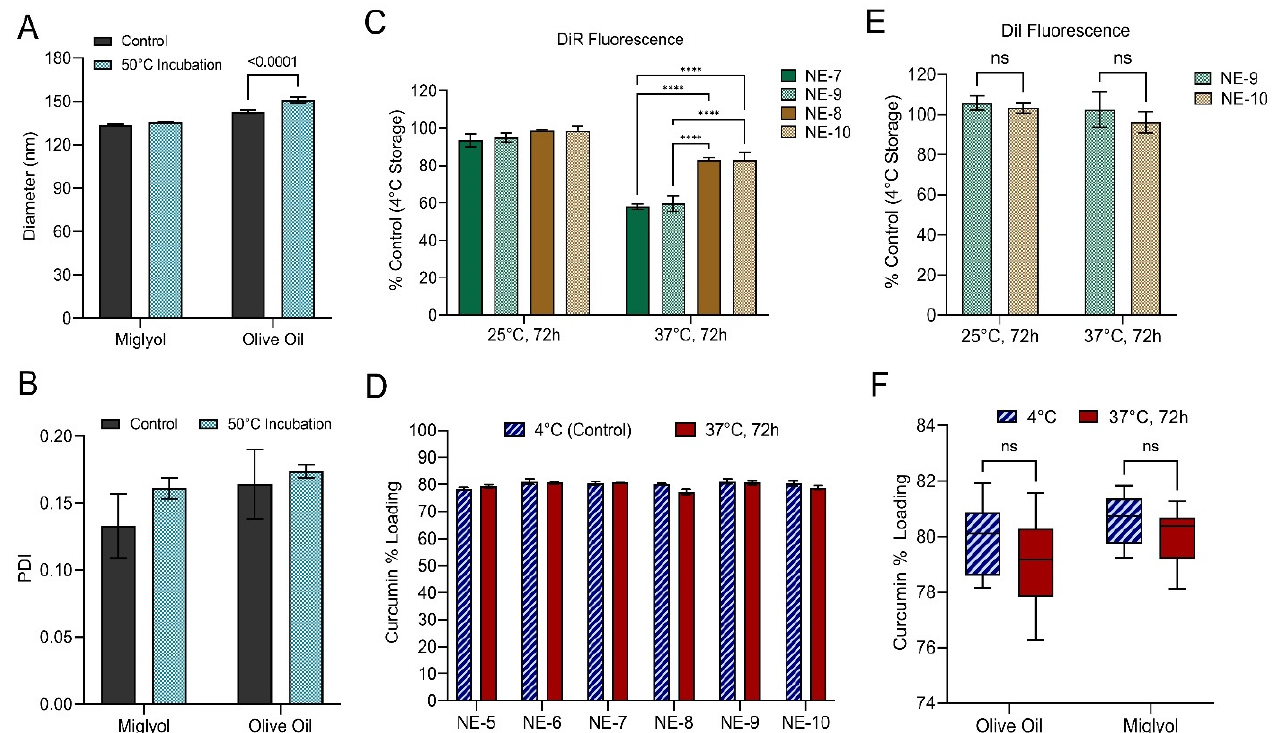
Figure 10. The impact of elevated temperature on nanoemulsion colloidal, fluorescence, and curcu- min loading stability. ( A , B ) Nanoemulsion ( A ) diameter and ( B ) PDI after incubation at 50 °C for 7 days. Values are the average ± standard deviation of three nanoemulsion batches. ( C , E ) Nanoemulsion fluorescence signal after 72h incubation at 25 or 37 °C. ( D , F ) Nanoemulsion curcumin loading after 72h incubation at 37 °C. Curcumin loading values are shown for ( D ) each nanoemulsion individually and ( F ) as the average of three nanoemulsions grouped by hydrocarbon oil. **** p -value < 0.0001; ns, no significance.